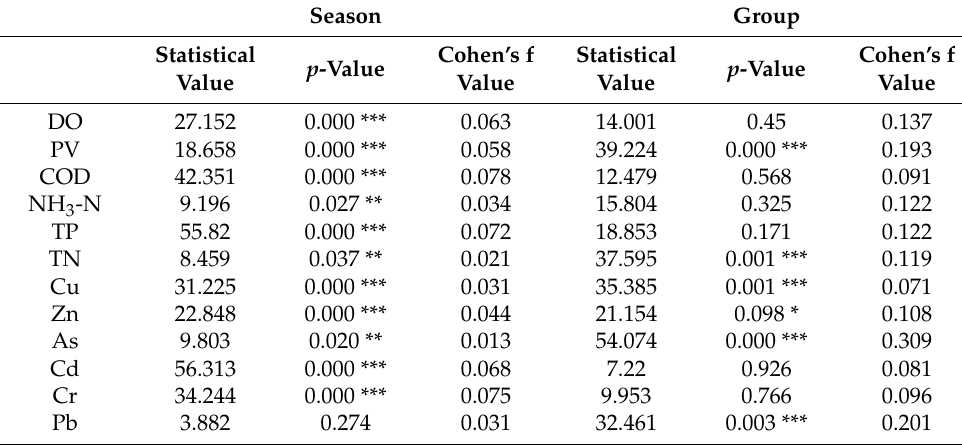
Table 3. Results of Kruskal–Wallis